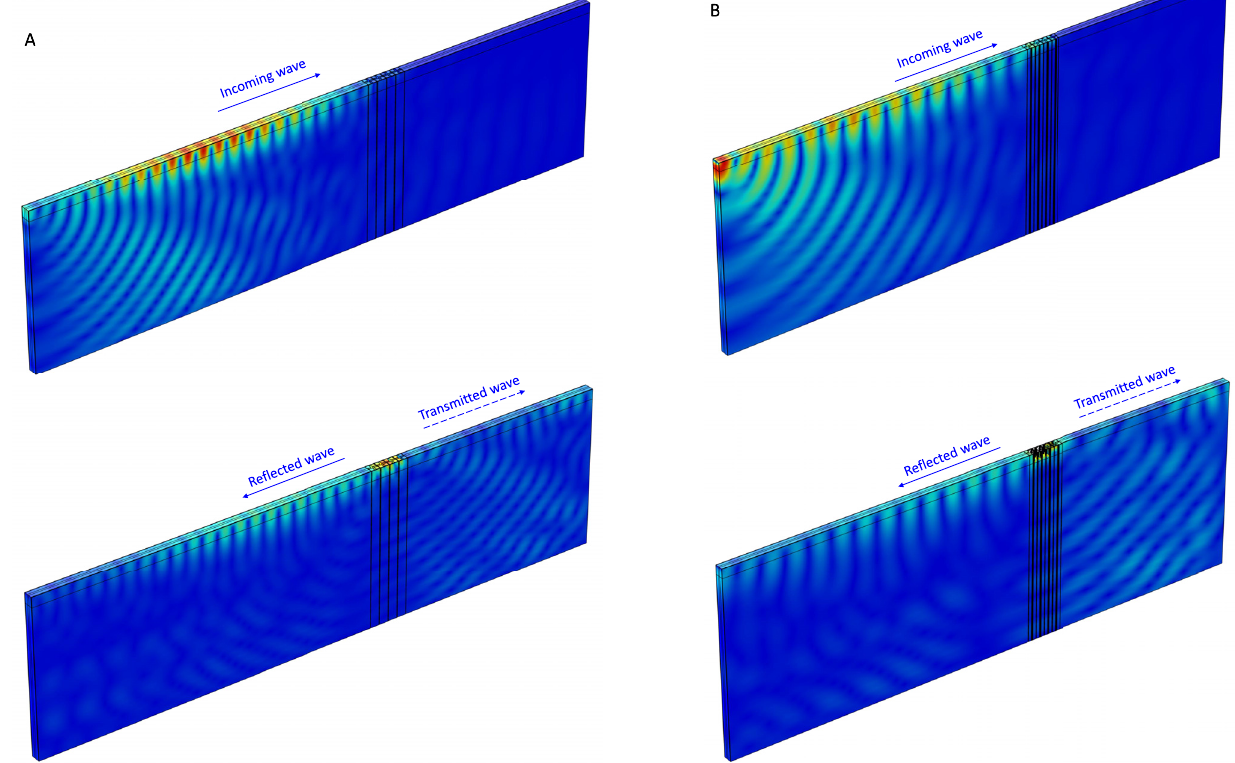
Fig. 5. Full wave fi eld reconstruction. Out-of-plane full wave fi eld for the (A) ordinary and (B) hierarchical seismic barrier at two different time steps: before (top panels) and after (bottom panels) the wave has reached the periodic